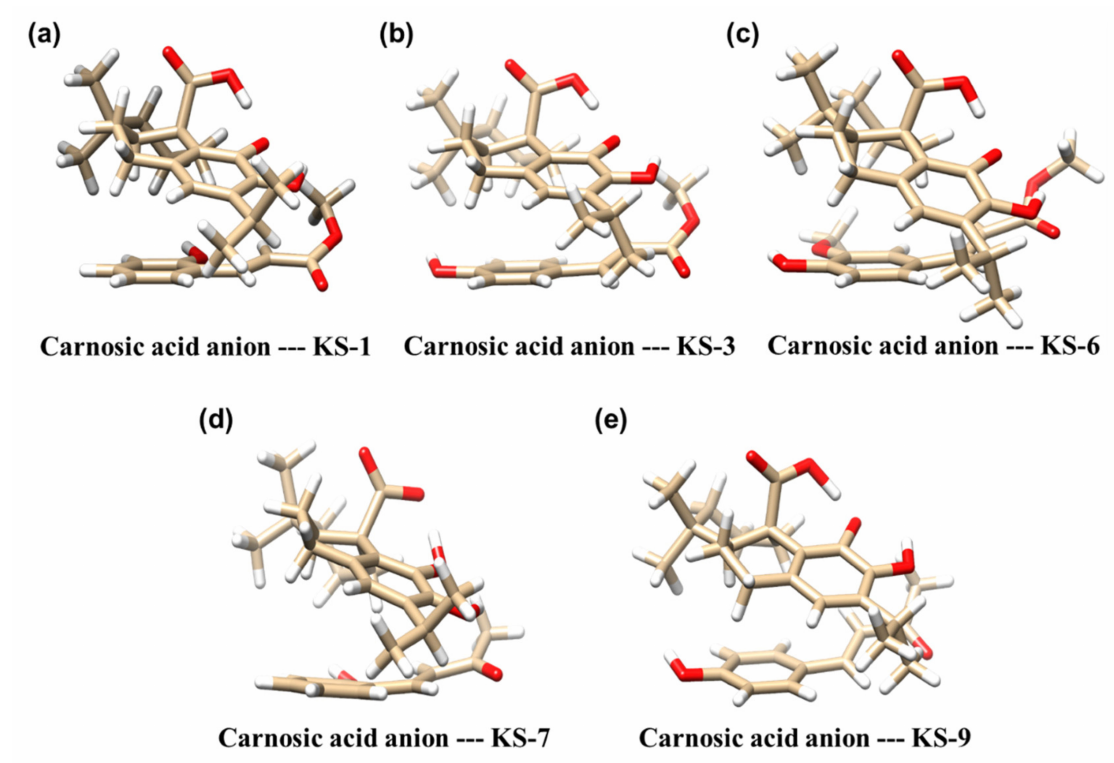
Figure 7. Molecular models of the complexes composed of the carnosic acid anion and selected KS compounds. The aromatic rings of the KS molecules are seen at the bottom of each complex ( a – e ). The carnosic acid anion is located above the aromatic ring of KS. The optimal structure of the carnosic anion in the complexes shows the intramolecular hydrogen bond -COO − — OH in the form of -COOH—O − as a result of proton transfer between oxygen atoms (see ( a – c , e )). The white, gold and red colors correspond to hydrogen, carbon and oxygen atoms,